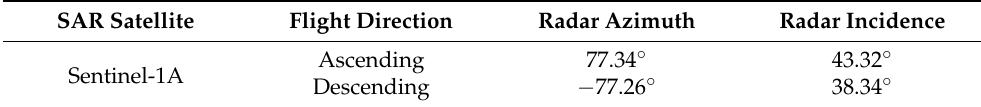
Figure 4. Acquisition dates and perpendicular baselines of ascending–descending Sentinel-1A datasets (with respect to the earliest SAR image in each dataset). Table 1. Orientation parameters of the satellite